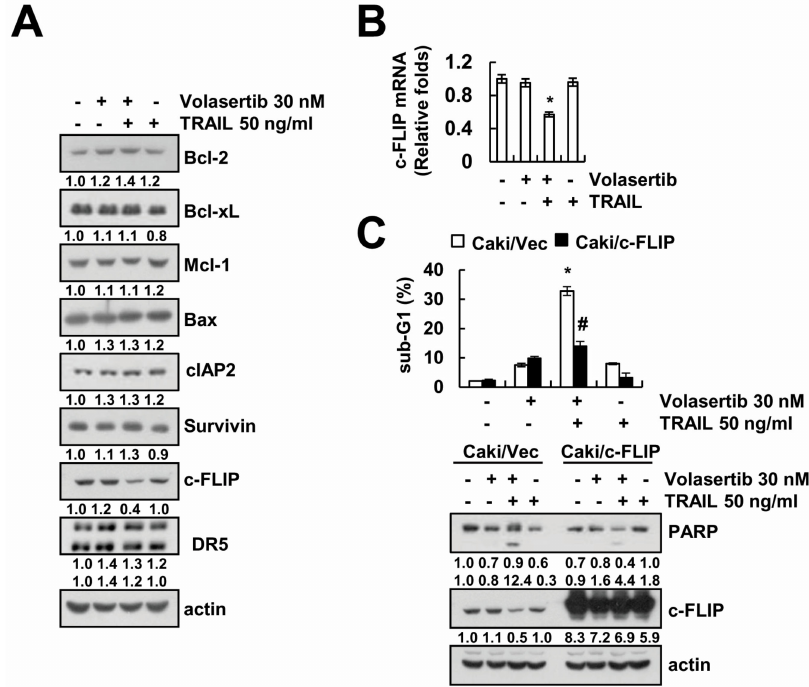
Figure 4. The downregulation of c-FLIP is associated with the induction of combined treatment-induced apoptosis. ( A , B ) Caki cells were treated with 50 ng/mL TRAIL in the presence or absence of 30 nM volasertib for 24 h. The protein expression levels of Bcl-2, Bcl-xL, Mcl-1, Bax, cIAP2, survivin, c-FLIP, DR5, and actin were determined via Western blotting ( A ). The mRNA expression levels of c-FLIP and actin were determined by qPCR ( B ). ( C ) Cells (Caki/Vec and Caki/c-FLIP) were treated with 50 ng/mL TRAIL in the presence or absence of 30 nM volasertib for 24 h. The sub-G1 fraction was detected via flow cytometry. The protein expression levels of PARP, c-FLIP, and actin were determined via Western blotting. The values in graphs ( B , C ) represent the mean ± SD from three independent samples. * p < 0.01 compared to the control. # p < 0.01 compared to volasertib plus TRAIL-treated